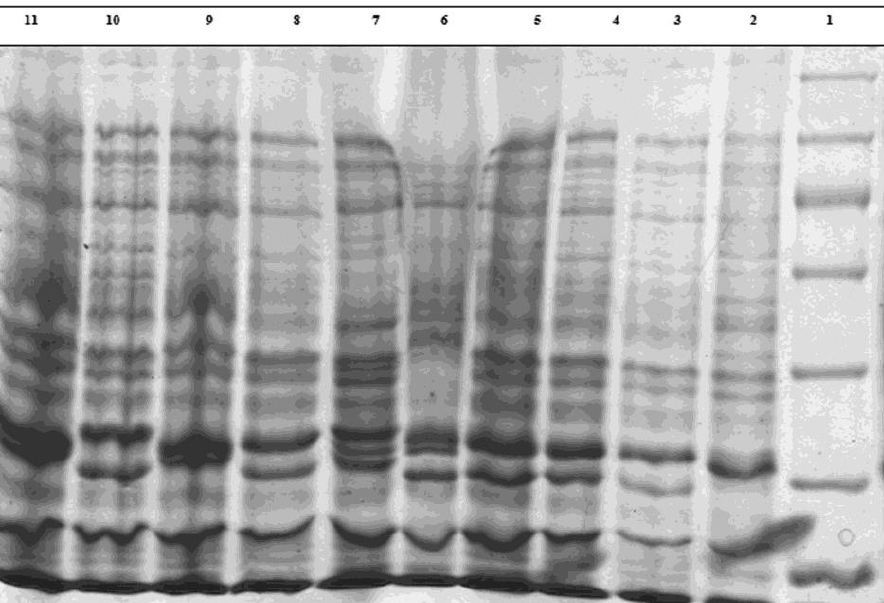
Figure 3. Sodium dodecyl sulfate – polyacrylamide gel electrophoresis whole-bacteria protein profiles of E. coli strains from milk. Lane 1, marker; Lane 2, reference strain E. coli ATCC 25922; Lane 3, E. coli strain 126; Lane 4, E. coli strain 14; Lane 5, E. coli strain 121; Lane 6, E. coli strain 8; Lane 7, E. coli strain 153; Lane 8, E. coli strain 119; Lane 9, E. coli strain 11; Lane 10, E. coli strain 140; and Lane 11, E. coli strain 77.